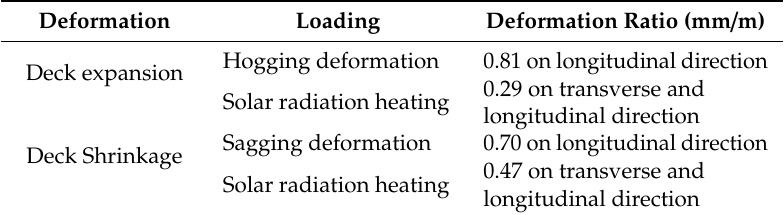
Table 5. Forced displacement acting on the